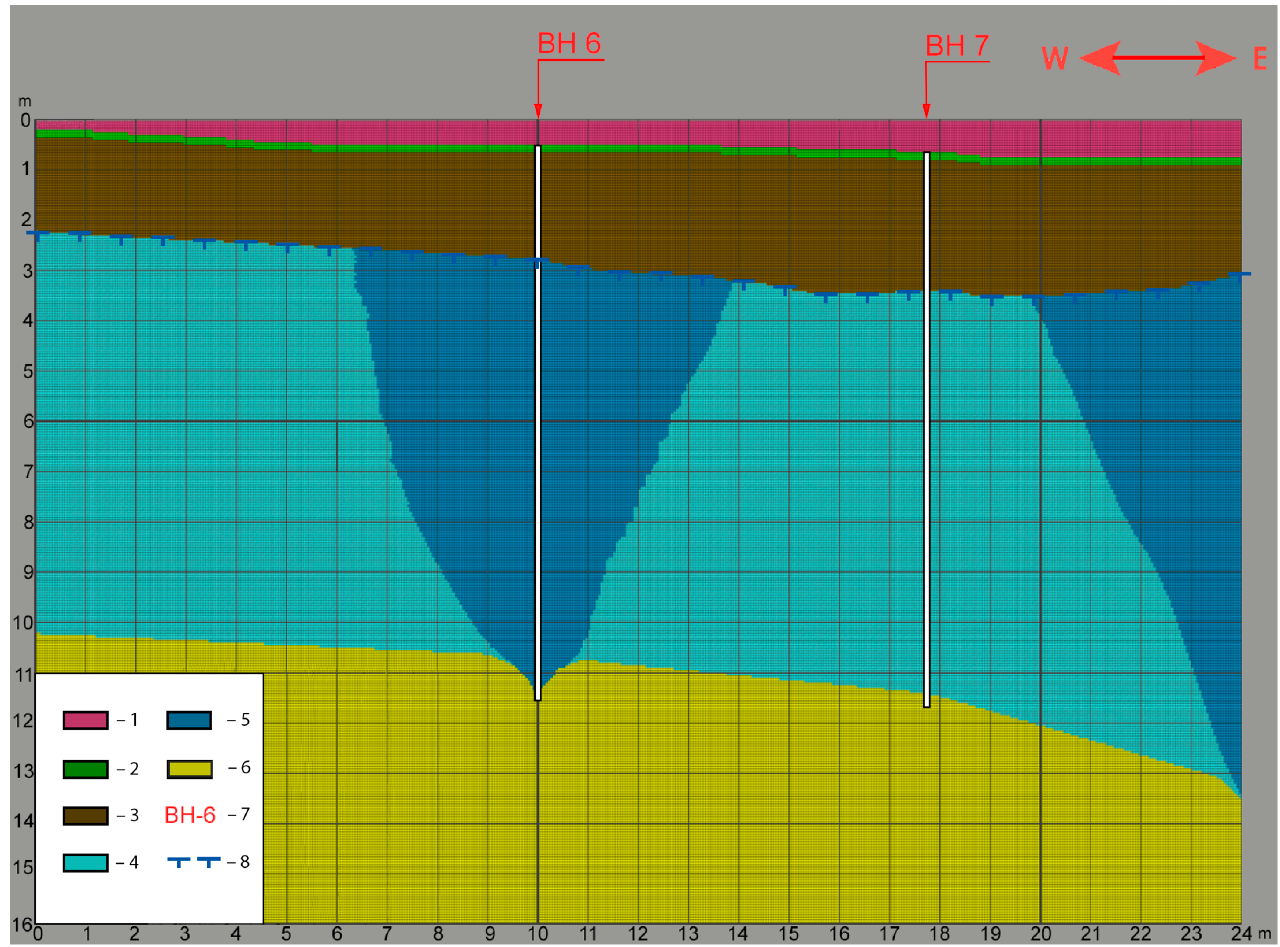
Figure 4. Computational domain. Legend: 1—atmosphere, 2—organic cover, 3—clayey silt, 4—sandy silt, 5—wedge ice, 6—sand, 7—borehole and its ID, and 8—top of permafrost. The mean monthly air temperatures and heat transfer coefficients in Amga for the last 10 years were applied as external parameters (Table 1) [44]. These were chosen be- cause the Roshydromet mean monthly temperatures (calculated normals from 1966) [45] are lower and do not consider climate change over the past 30 years. Table 1. Mean monthly values of air temperature and heat transfer coefficients.